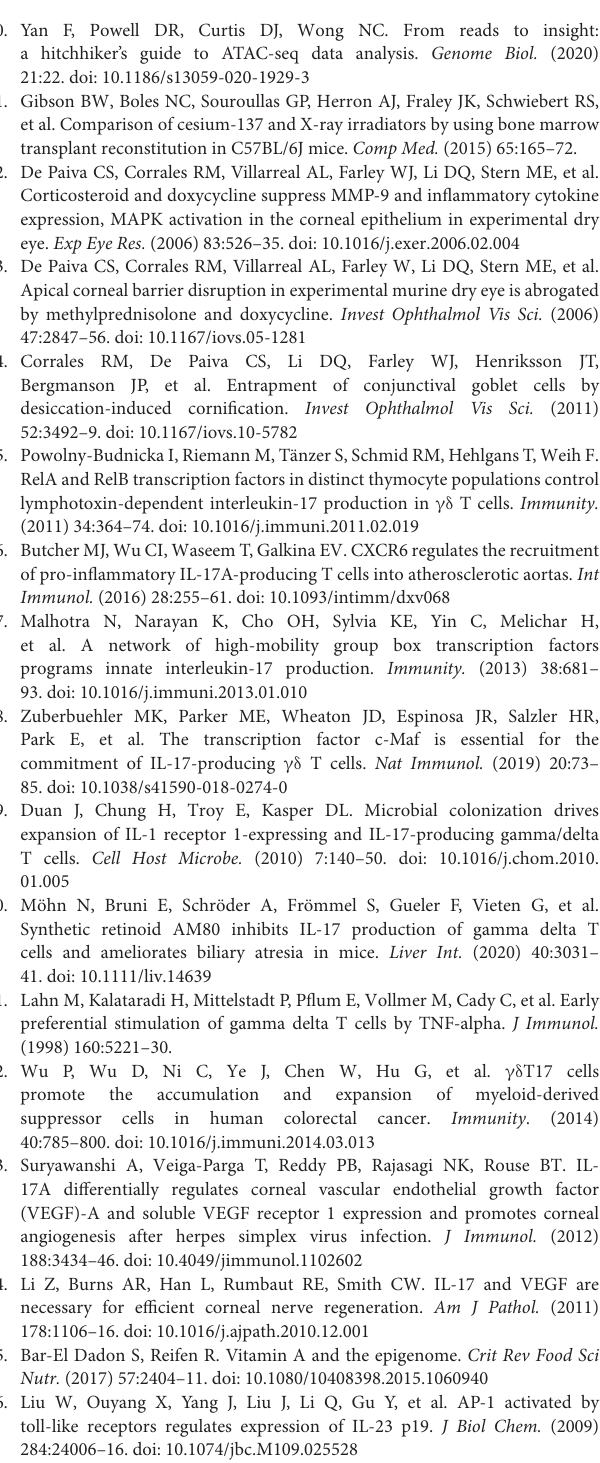
Supplementary Table 1 | Antibodies in this study. Supplementary Table 2 | Top differentially expressed genes in cell clusters. Supplementary Table 3 | Differentially expressed genes per cell